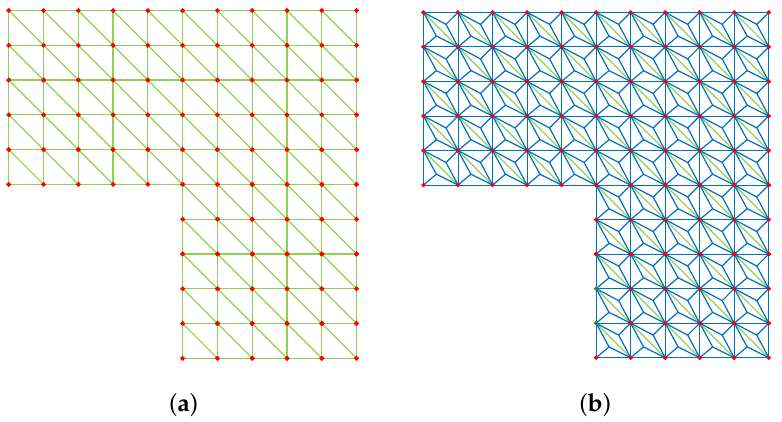
Figure 7. ( a ) A mesh computational model with 150 triangular elements and ( b ) a computational model after constructing the smoothing domain.